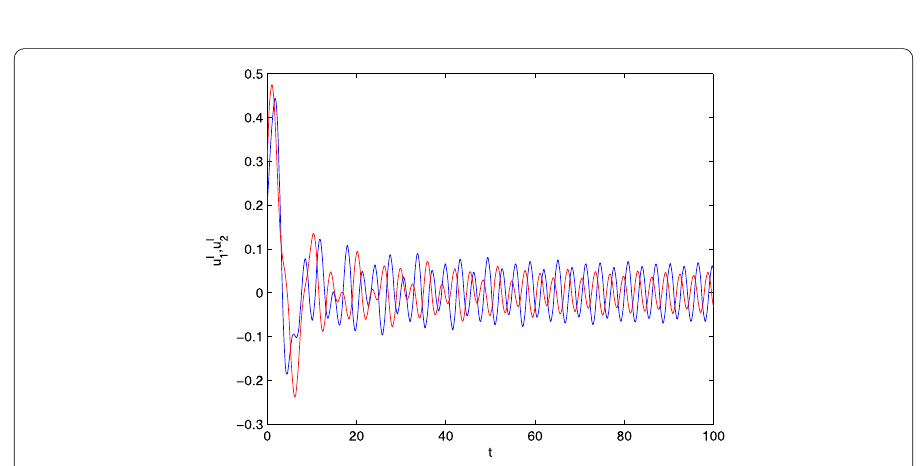
Figure 2 The anti-periodic solution of model (5.1): t – u I 1 and t – u I 2 . The blue line stands for u I 1 and the red line stands for u I